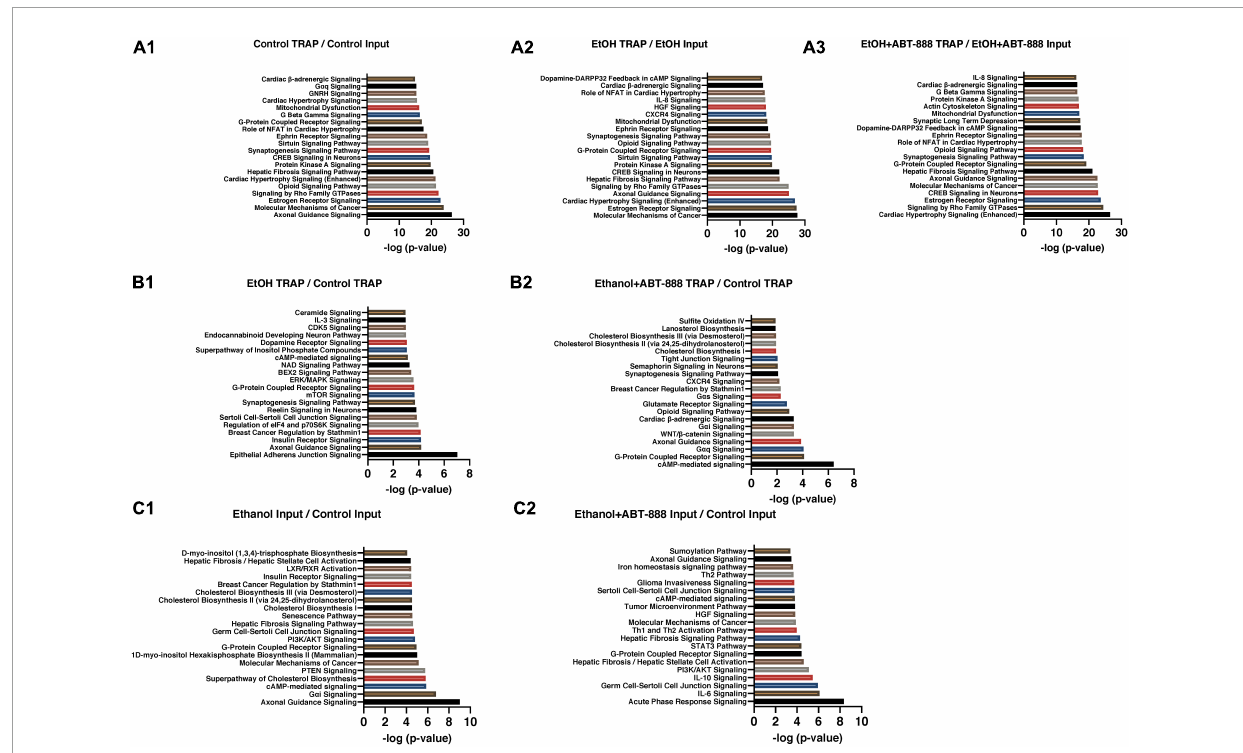
FIGURE1 Top IPA canonical pathways enriched in gene lists from Table 1 . The top 20 significantly enriched canonical pathways based on IPA coordinated with Table 1 . (A) TRAP-seq (RE fraction) compared to RNA-seq (total-RNA) for control, EtOH treated, and ABT-888 treated. Panels (A1–A3) from Table 1 . (B) TRAP-seq of EtOH treated compared to control, and ABT-888 treated compared to control. Panels (B1, B2) from Table 1 . (C) RNA-seq of EtOH treated compared to control and ABT-888 treated compared to control. Panels (C1, C2) from Table 1 . The pathways are ranked according to IPA generated –log p -value scores, and the pairwise comparisons were sorted using FDR < 0.01 for panels (A1–A3) comparisons and FDR < 0.05 for panels (B1–C2) comparisons.